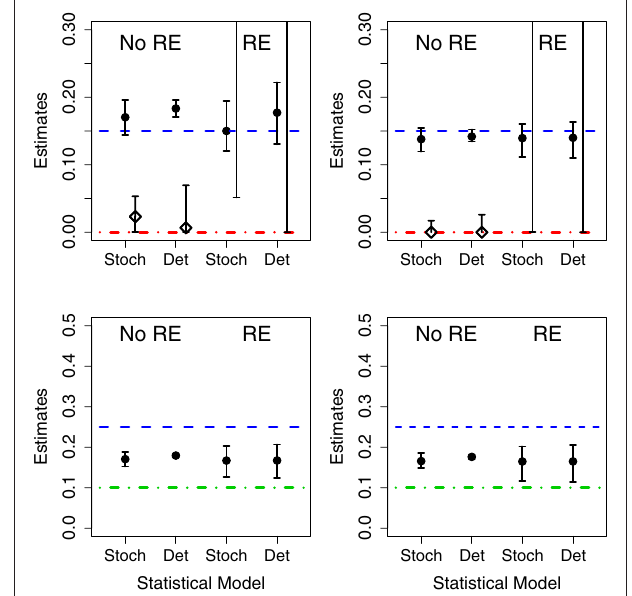
FIGURE 3 | Results of fits when using mismatched structural models. The symbols correspond to the estimates of the growth rate (circles) and death rates (diamonds) under different scenarios. In the (Left) , the data was generated without parametric variability and in the (Right) the data was generated with parametric variability. Top row: results of fits with a birth-death model to data generated by a pure birth process. In each case, we used stochastic or deterministic fits, without (“No RE”) or with (“RE”) random effects. The horizontal dashed blue lines indicate the value µ A (birth rate) and the dot-dashed red line the value of σ A used in the data generation. Bottom row: results of fits with a pure birth model to data generated by a birth-death process. The horizontal dashed blue lines stand for µ A and the dot-dashed green lines for µ B . In all cases, the vertical whiskers are the 95% CI obtained in the fits. Note that the estimates of the death rate for the random effects fits (in the top panel) are off the plot, and only the bottom segments of the whiskers are